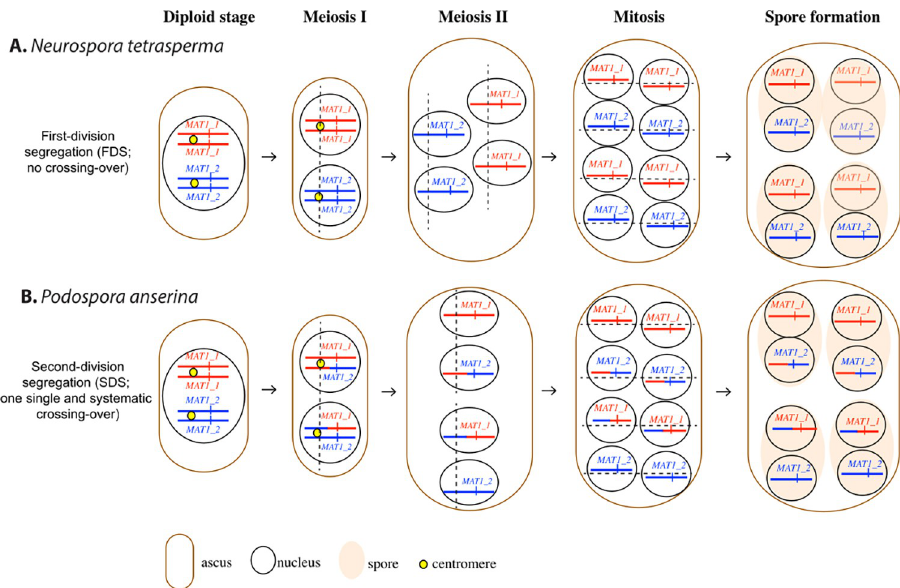
Fig 1. Mating-type segregation and nuclei compaction in spores during ascus development in the pseudo- homothallic fungi Neurospora tetrasperma (A) and Podospora anserina (B) ( Sordariales , Ascomycota ). In each panel, five stages are represented from left to right: the diploid cell before meiosis with a nucleus heterozygous at the mating-type locus; the first division of meiosis (meiosis I); the second division of meiosis (meiosis II); the post-meiotic mitoses (PMM); and the spore formation with the compaction of non-sister nuclei in N . tetrasperma and sister nuclei in P . anserina . Only the chromosomes carrying the mating-type locus are represented, with their centromeres. The opposite MAT1-1 and MAT1-2 alleles at the mating-type locus are represented by red and blue vertical bars, respectively. The mating-type locus segregate at meiosis I in N . tetrasperma and at meiosis II in P . anserina . During meiosis II, spindles are parallel in N . tetrasperma and aligned in P . anserina . The standard nomenclature of mating- type alleles is used, with MAT1-2 corresponding to the mat+ and mat_a allele and MAT1-1 to the mat- and mat_A allele in P . anserina and N . tetrasperma , respectively. Centromeres are represented by yellow circles at the diploid and meiosis I stages. Chromosomal arms are colored in red or blue according to the parental origin of the chromosomal fragment. Spindle orientations in meiosis and mitoses are indicated by dotted line. The figure was adapted from Ref (4).